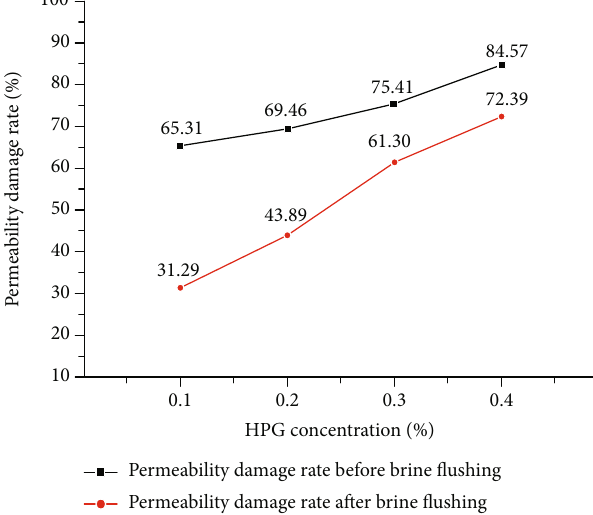
Figure 8: Permeability changes before and after brine fl ushing at di ff erent fracturing fl uid